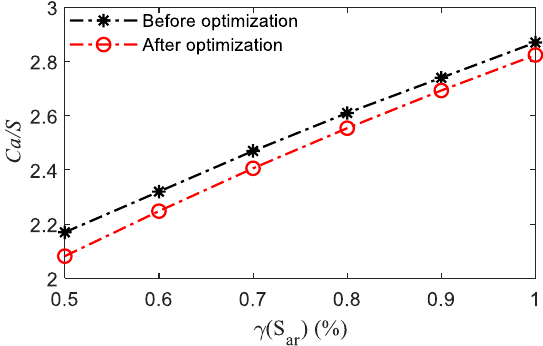
Figure 10. Ca/S comparison before and after